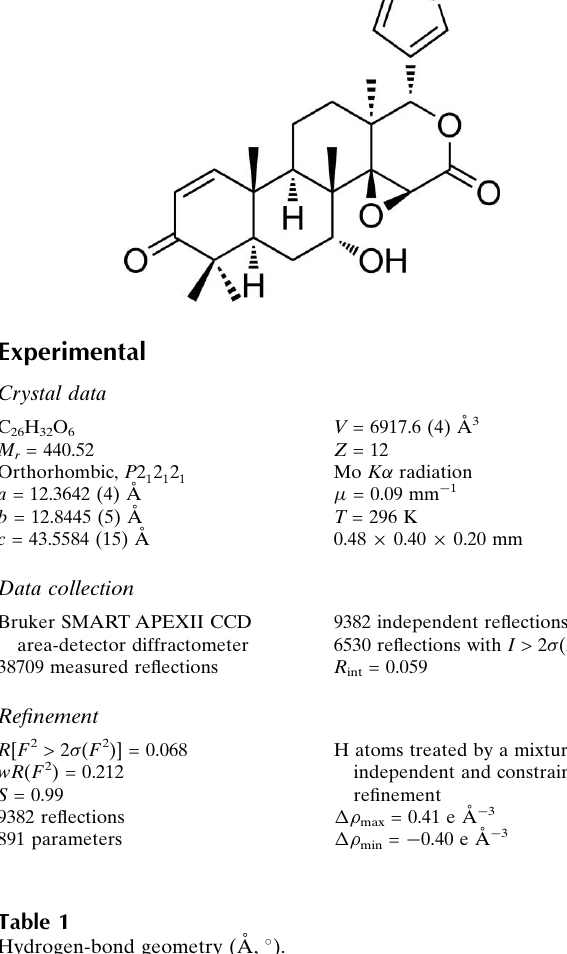
Hydrogen-bond geometry (A˚ , (cid:5)